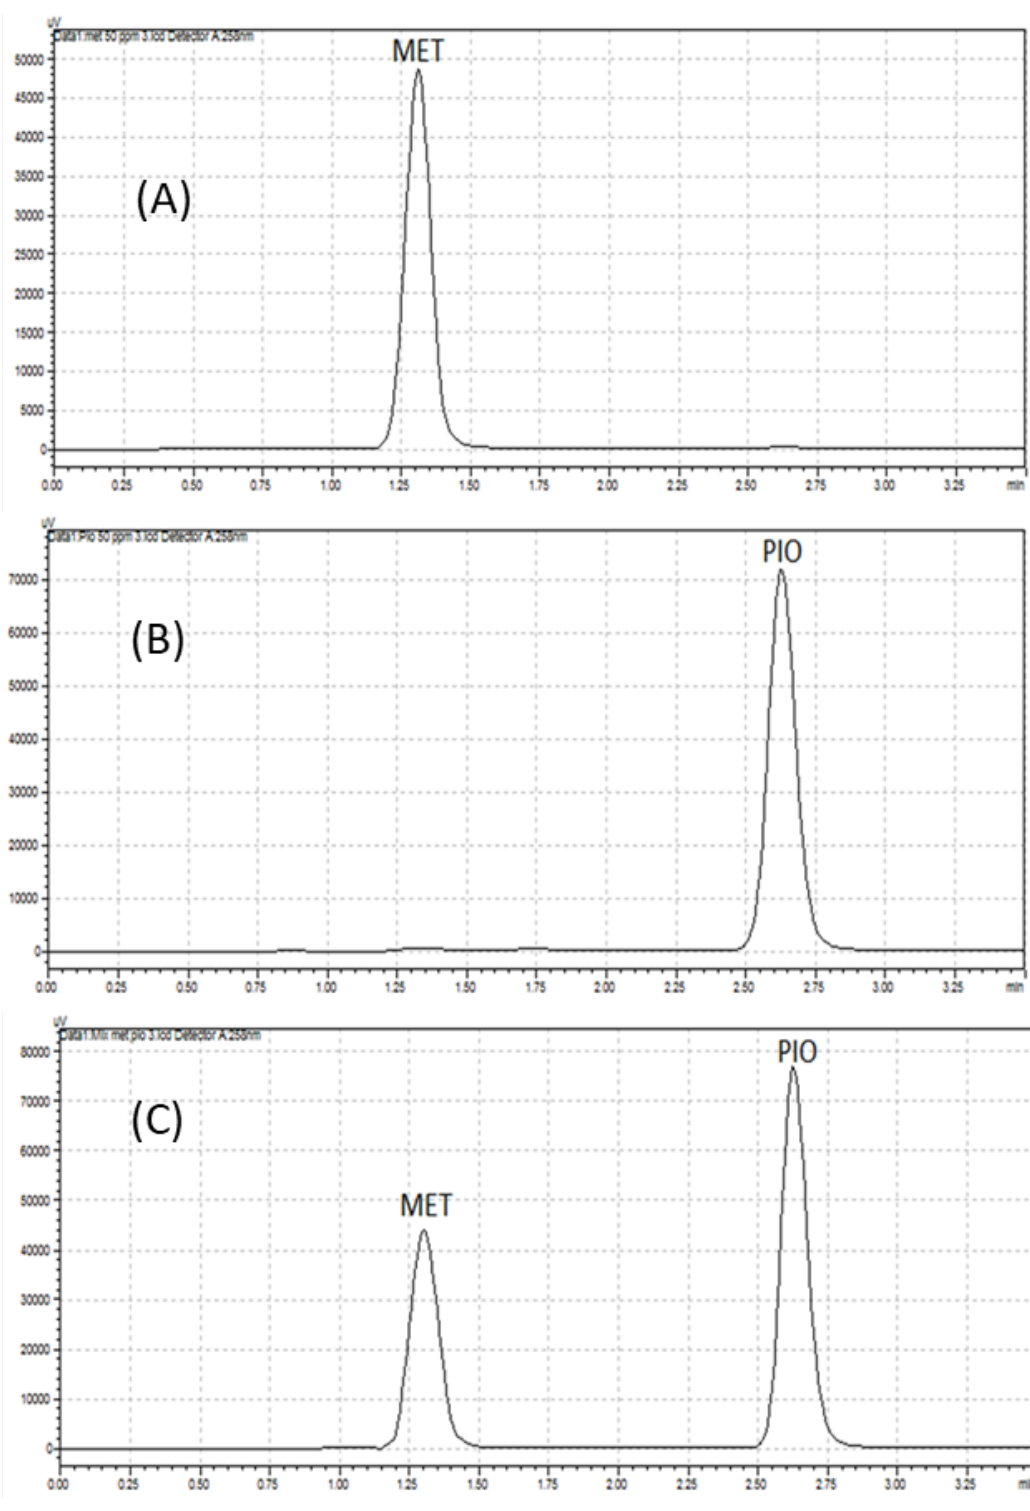
Figure 4. Typical chromatograms for application of high-performance liquid chromatography method for the analysis of ( A ) 50 µ g/mL metformin (MET) in (glucophage ® ) ( B ) 80 µ g/mL pioglitazone (PIO) in (actos ® ) ( C ) 50 µ g/mL metformin (MET) and 80 µ g/mL pioglitazone (PIO) in synthetic mixture.